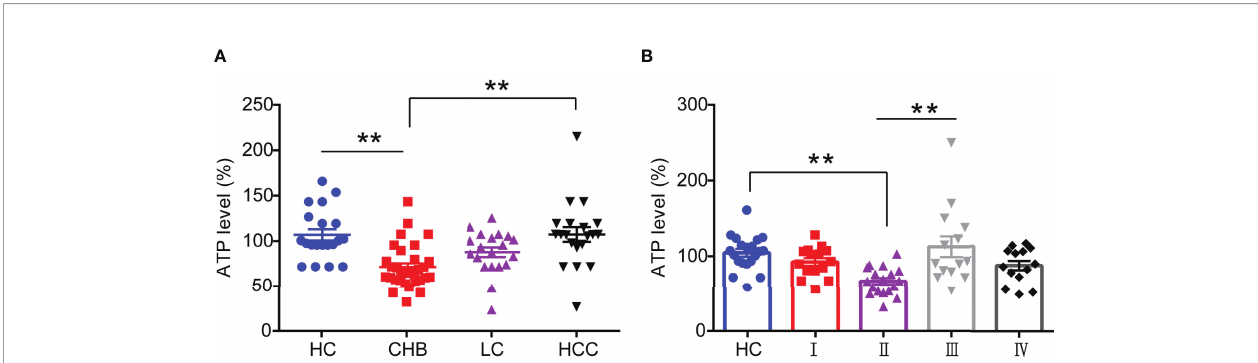
FIGURE 1 | Serum ATP is signi fi cantly decreased in patients with HBeAg-positive CHB. (A) The level of serum ATP from healthy control (HC) (n=20), chronic hepatitis B (CHB) (n=32), liver cirrhosis (LC) (n=20), and hepatocellular carcinoma (HCC) (n=20). (B) The level of serum ATP across the natural history of chronic HBV infection, HC (n=20), HBeAg-positive chronic HBV infection (I) (n=15), HBeAg-positive CHB (II) (n=20), HBeAg-negative chronic HBV infection (III) (n=15), and HBeAg- negative CHB (IV) (n=15). Data are presented as means ± SEM, ** p < 0.001; one-way ANOVA post-hoc Student – Newman – Keuls